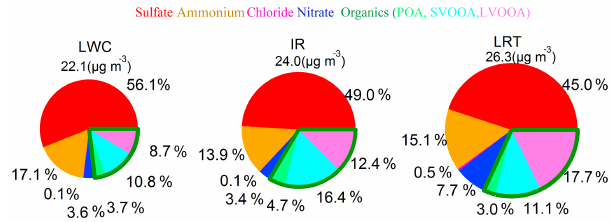
Figure 1. Chemical constituents NR-PM 1 in LWC, IR and LRT episodes (LWC: medium-range transport with high LWC and low IR; IR: medium-range transport with high IR and low LWC; LRT: long-range transport).